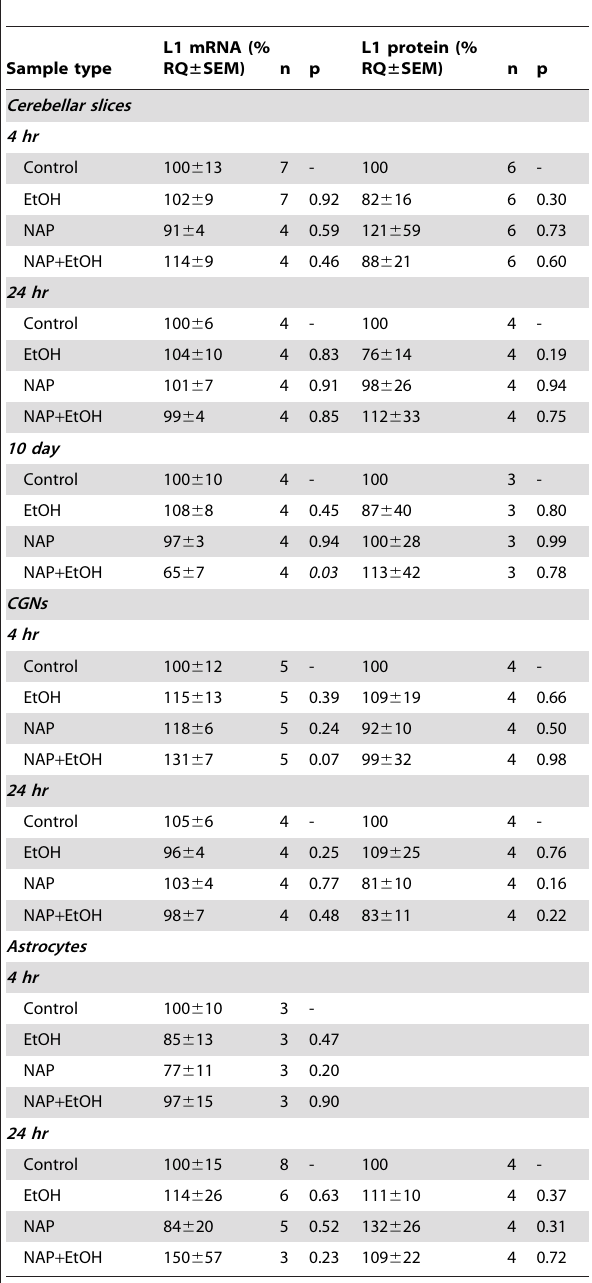
Table 1. Summary of ethanol and NAP effects on L1 mRNA and protein expression in three cerebellar culture systems.